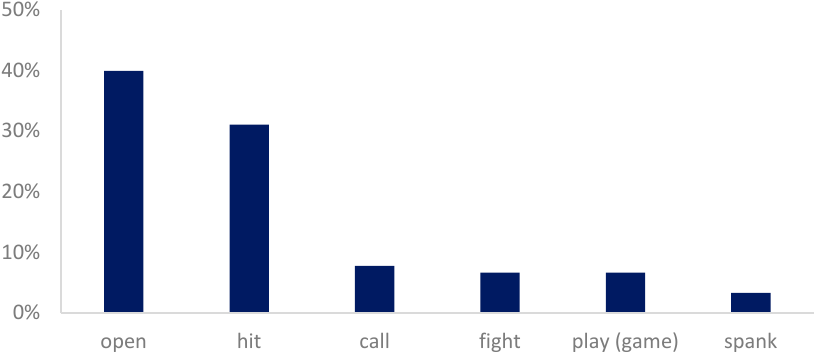
打 dˇa in the first 10 tokens by all the Figure 3. Proportions of the senses of 打 d ǎ in the first 10 tokens by all the children. Figure 3. Proportions of the senses of